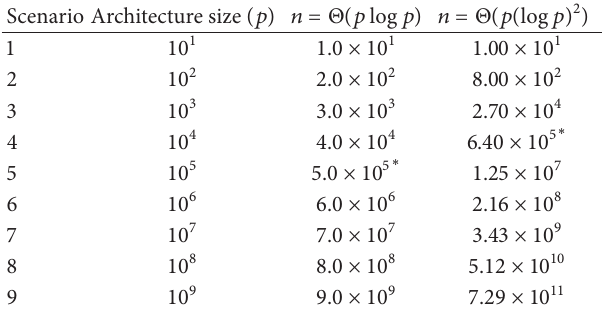
Table 2: Isoefficiency for a hypercube architecture: 𝑛 = Θ(𝑝 log 𝑝) and 𝑛 = Θ(𝑝( log 𝑝) 2 ) . We marked with ( ∗ ) the limitations imposed by Formula